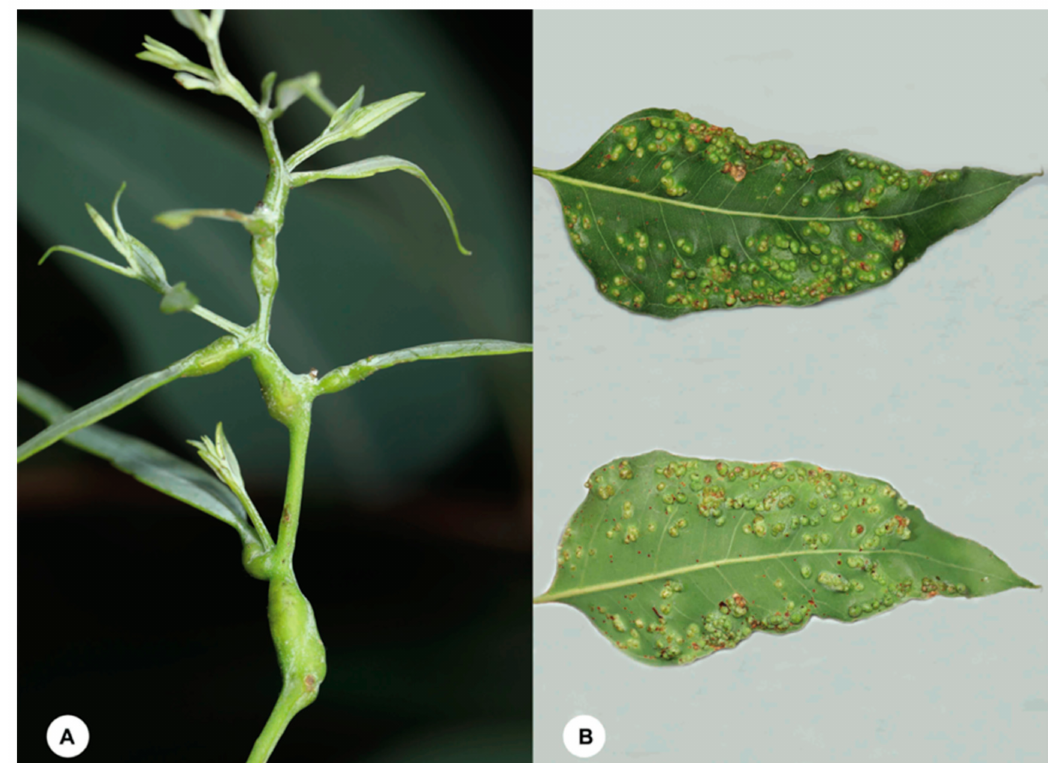
Figure 1. ( A ) Galls of Leptocybe invasa Fisher & La Salle on Eucalyptus exserta F. Muell. ( B ) Galls of Ophelimus bipolaris sp. n. on Eucalyptus urophylla S. T. Blake. (All photographed in Guangzhou, China).